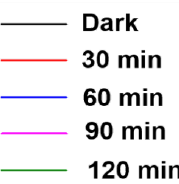
Figure 6. Regeneration of NADH from NGQDs (black line) and NGQDs@EC (red line) photocatalyst respectively.